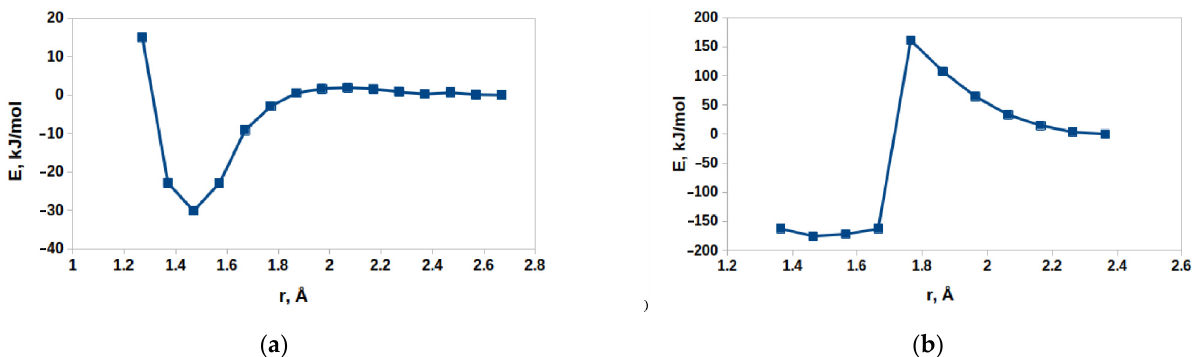
Figure 16. RSS energy profiles of ( a ) the HOO − attack and ( b ) the rearrangement. Each point depicts the energy of the species yielded by the constrained optimization with the corresponding constraint value imposed to the scanned distance. The connecting lines were added solely for guiding the